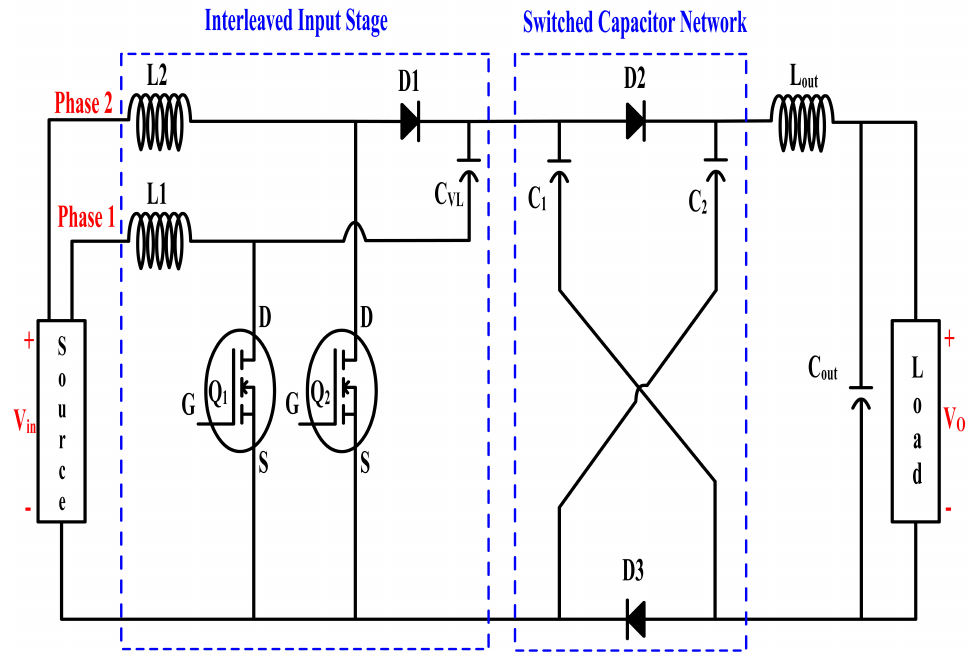
Figure 1. Power circuit diagram of the proposed